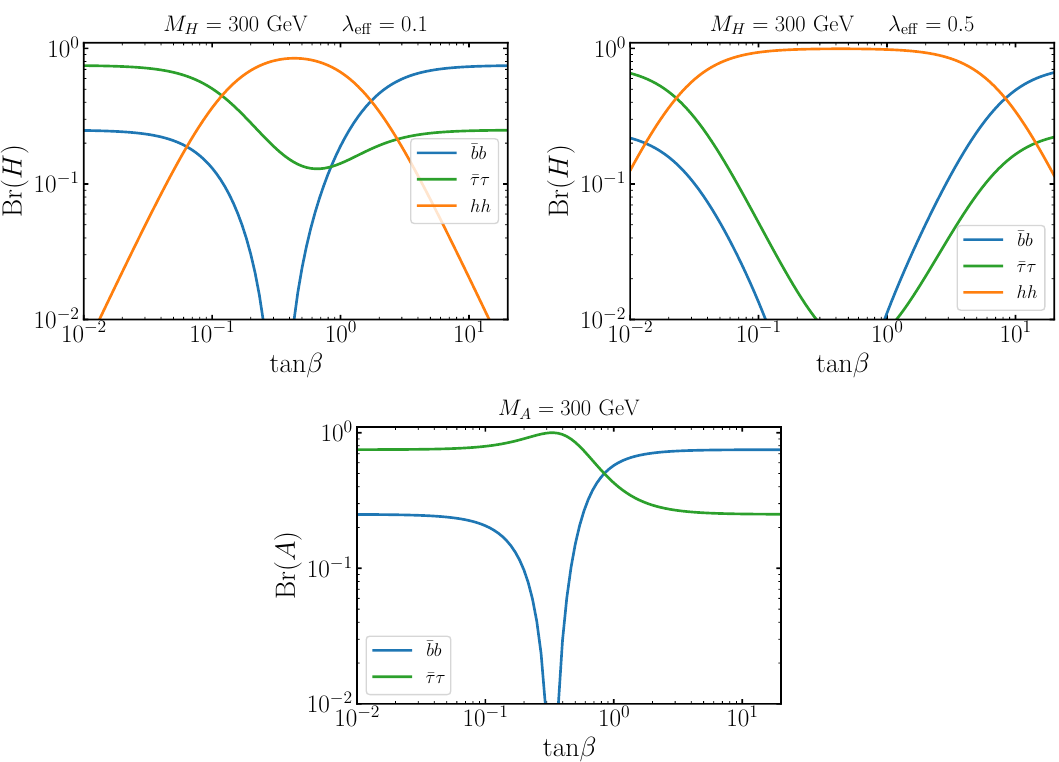
Figure 1 . Branching ratio for the different decay channels of H and A as a function of the parameter tan β . In the upper panel, the two different plots corresponds to different values for the H − h − h coupling λ eff and we fix M H,A = 300 GeV